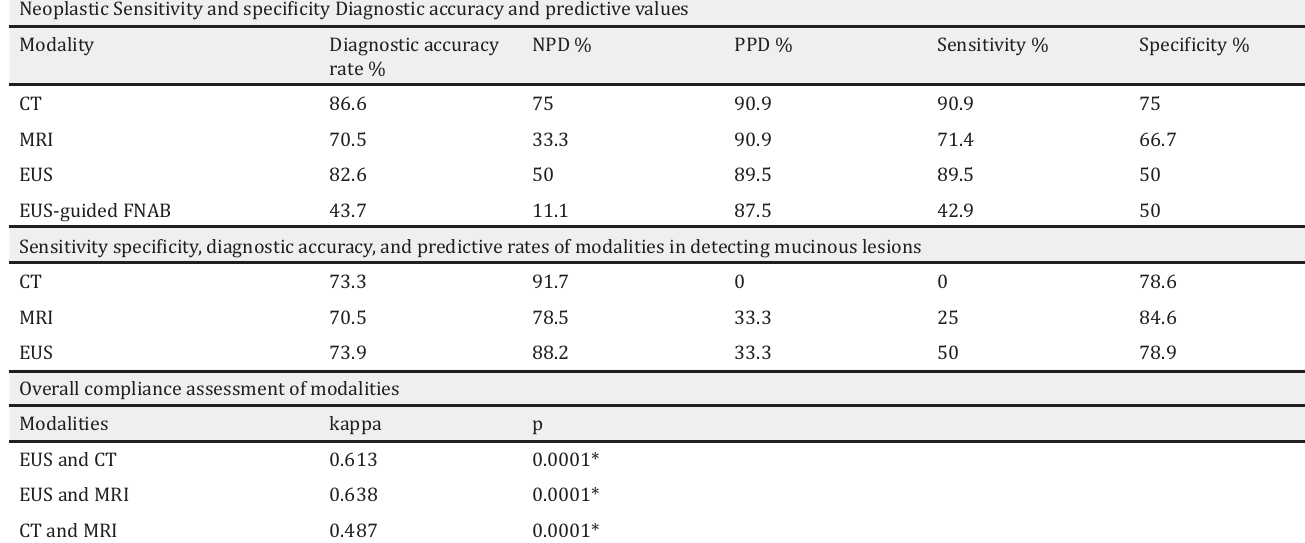
Diagnostic performance of CT, MRI, EUS and EUS-guided FNAB in cystic lesions of the